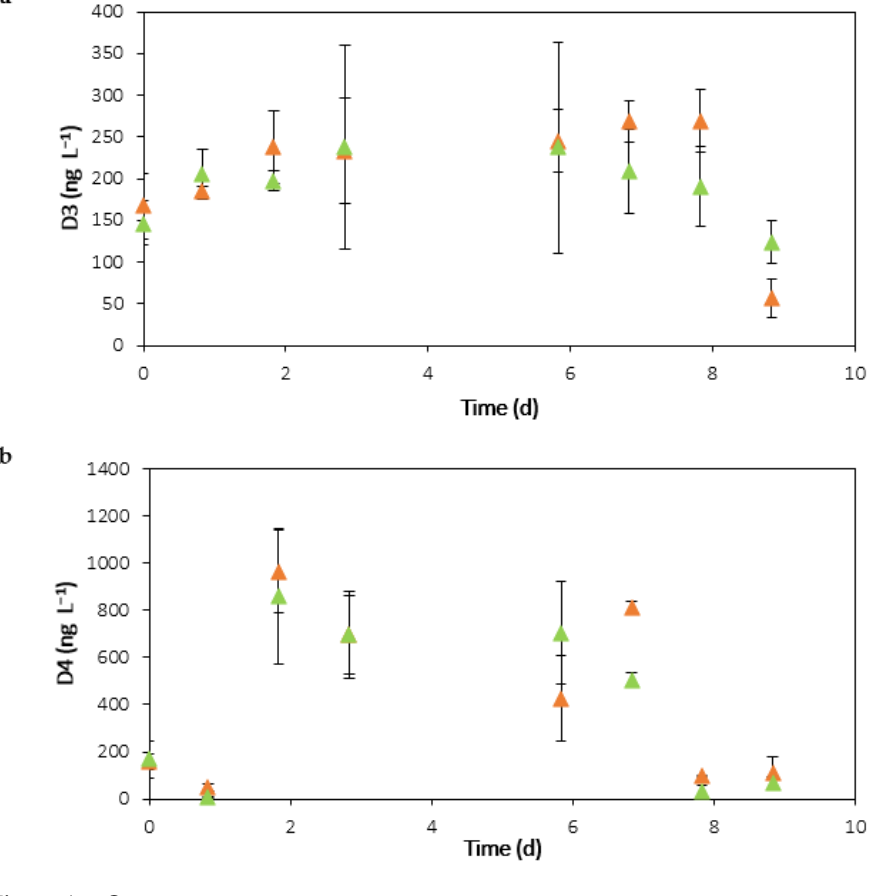
Figure A1. Time-course evolution of D3 ( a ), D4 ( b ) and D6 ( c ) concentrations for the C-PE and PE experiments. References 1.